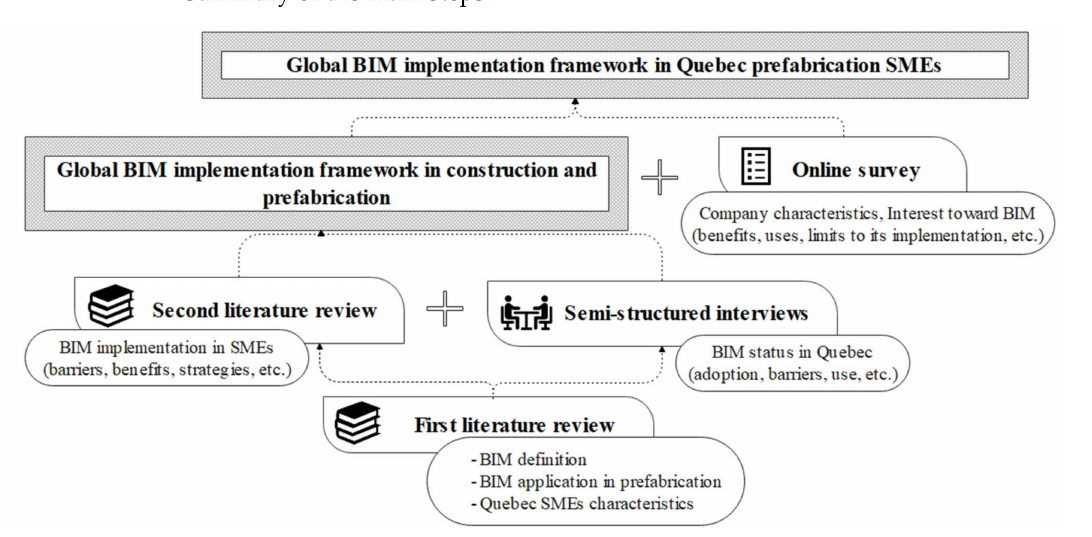
Figure 1. Research